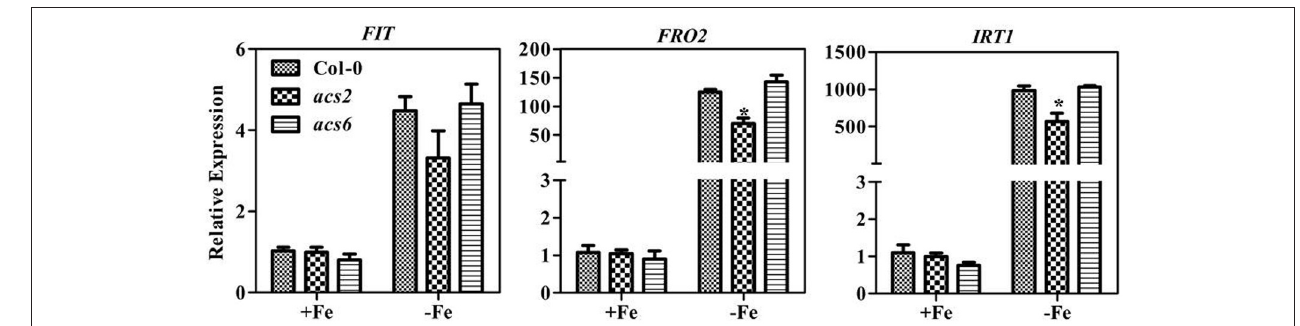
Frontiers in Plant Science |